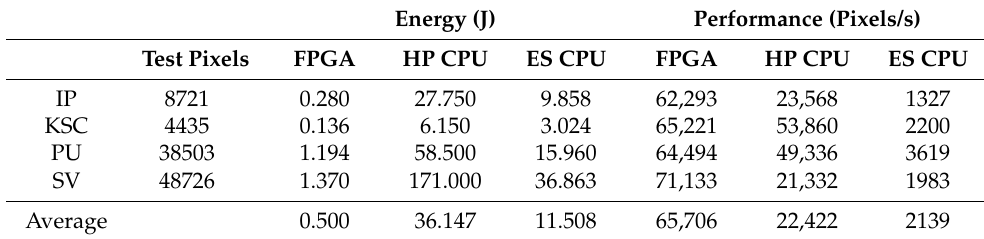
Table 4. Energy and performance